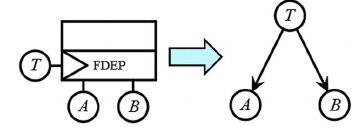
Figure 5. FDEP gate and its corresponding CTBN